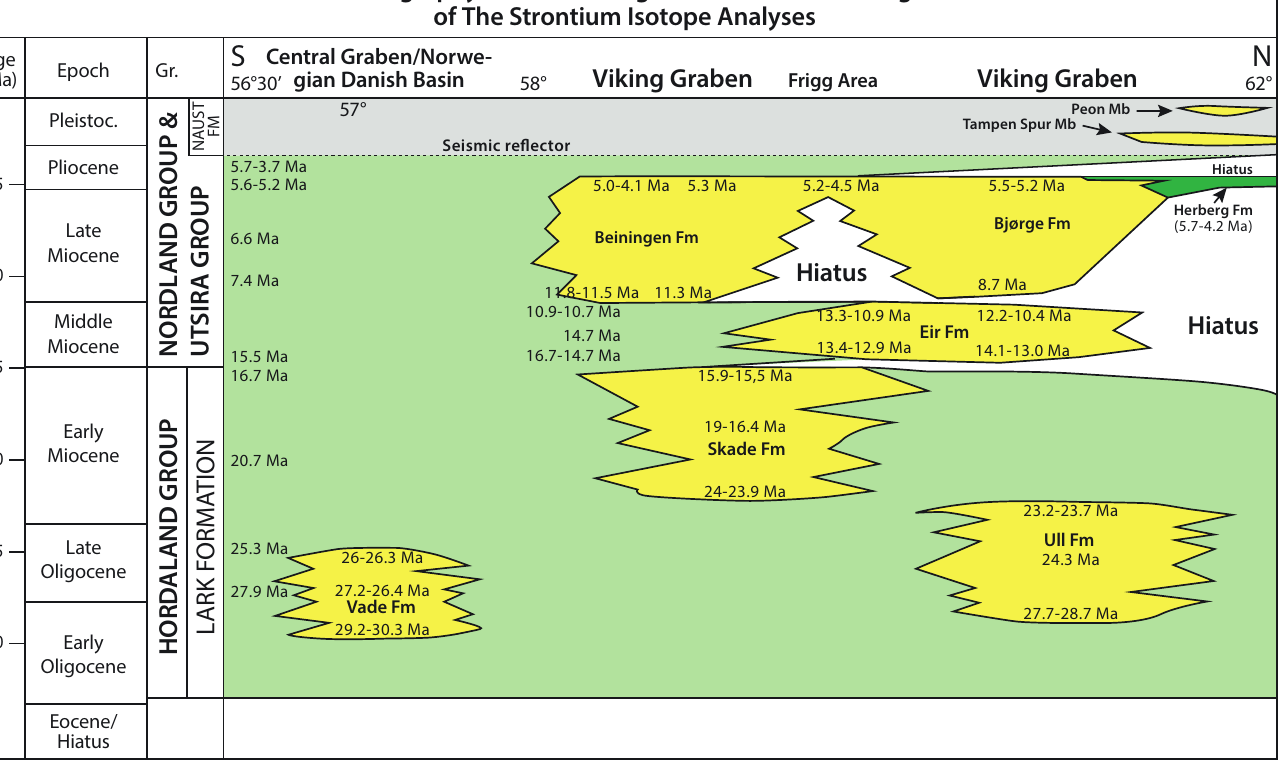
Figure 18. Post-Eocene lithostratigraphy of the Norwegian North Sea including main ages obtained from strontium isotope analyses based on fossil tests interpreted Fig. to be in situ (modified after Eidvin et al., 2013d).